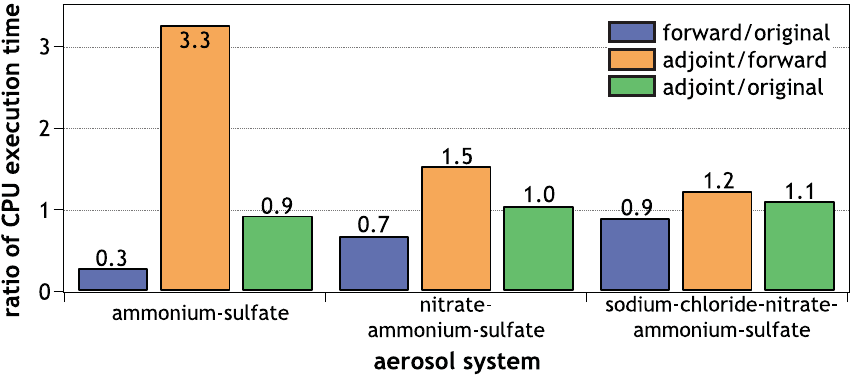
Fig. 5. The ratios comparing CPU execution time for the calculations of ANISORROPIA forward concentrations (forward), ANISOR- ROPIA adjoint sensitivities (adjoint), and ISORROPIA v.2.1 forward concentrations with double precision activity coefficient calculations (original) are shown. Experiments were designed to elucidate the ratios for each of the aerosol systems treated in ANISORROPIA (SO 2 − HSO − -NH + -H 2 O; NO − -SO 2 − -HSO − -NH + -H 2 O; Na + -Cl − -NO − -SO 2 − -HSO − -NH + -H 2 O). The forward/original comparison reveals 4 4 3 4 4 4 3 4 4 4 the reduced time required because of algorithmic changes necessary for adjoint